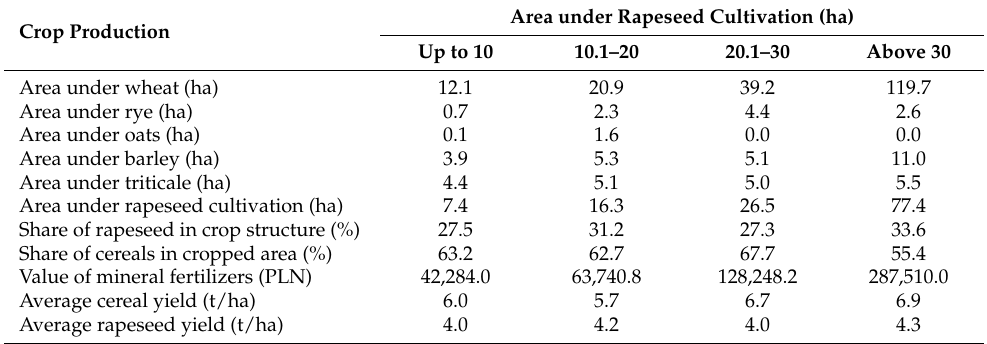
Table 4. Crop production in the analyzed farms with different area under rapeseed cultivation